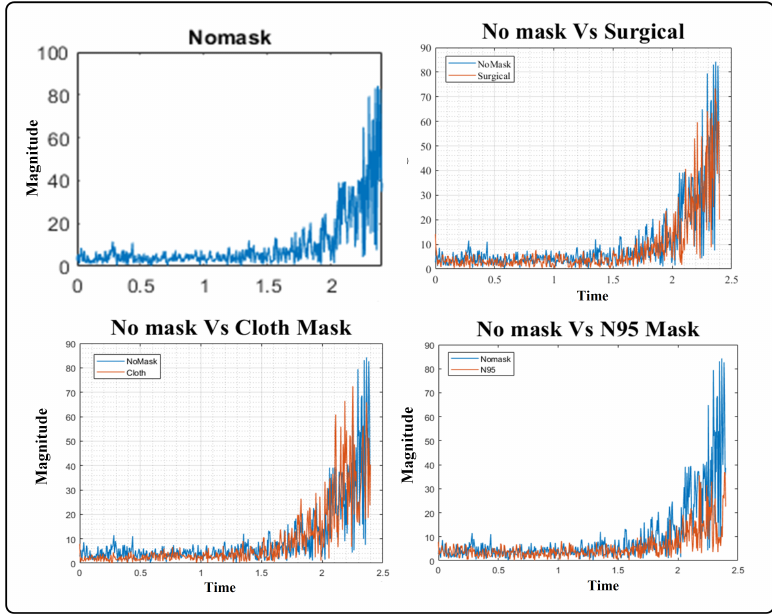
Figure 2. Comparison of different masked speech samples against samples without a